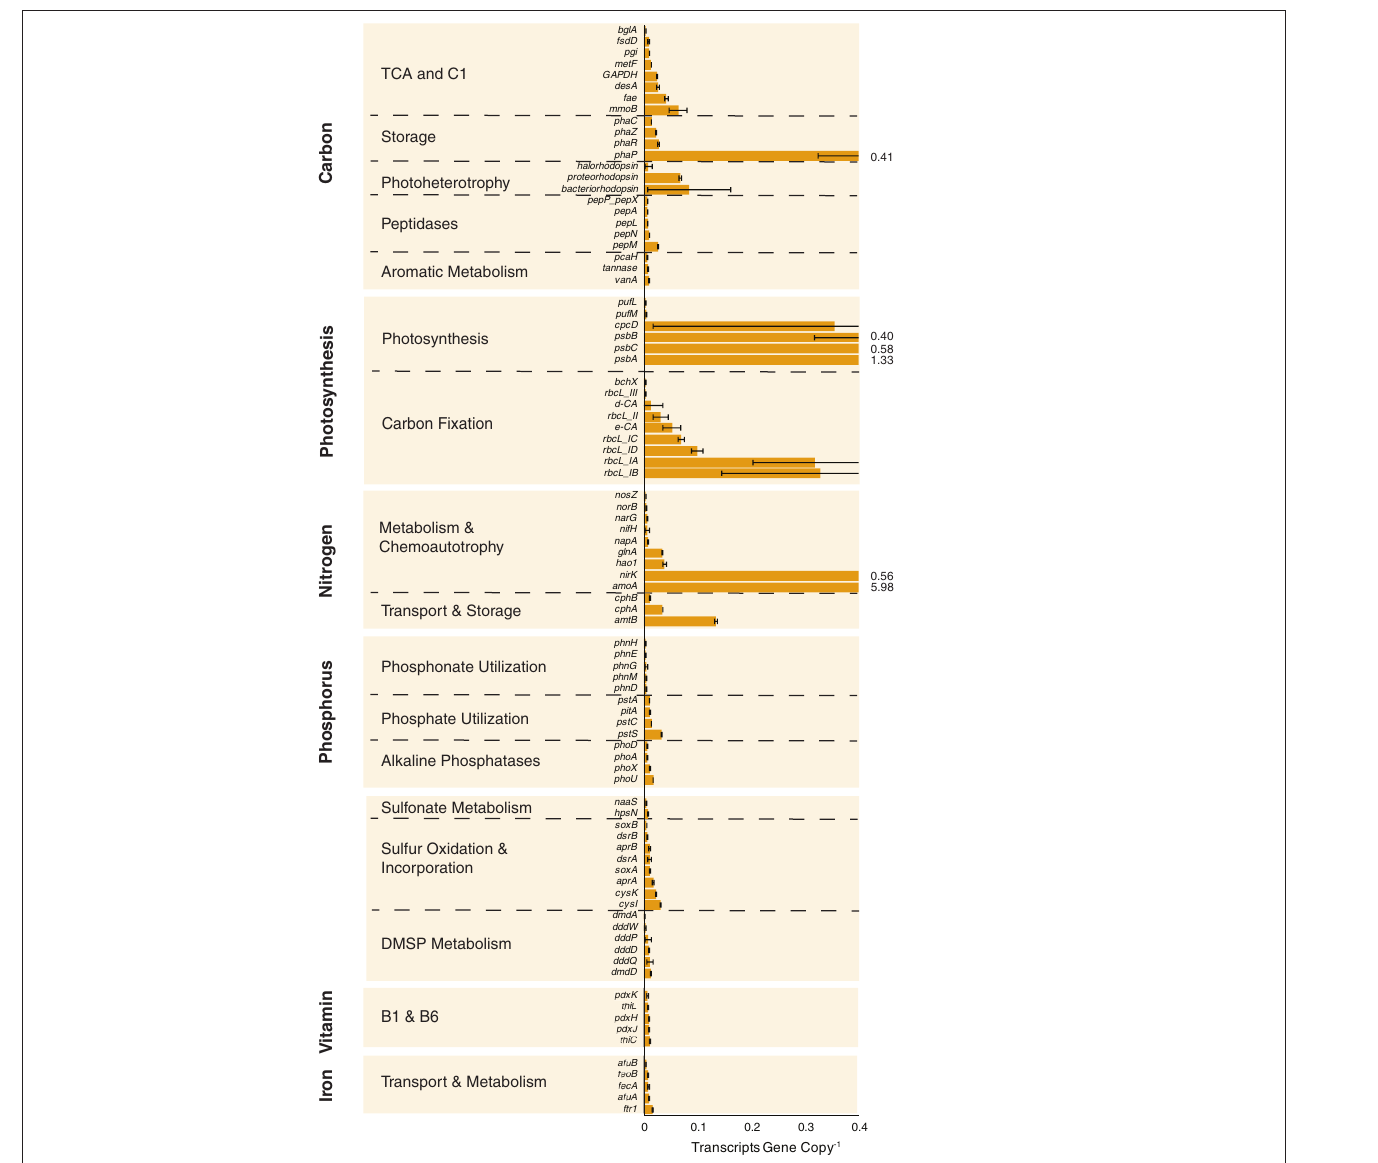
FIGURE 2 | Expression ratios (transcripts gene copy − 1 ) for 89 biogeochemically-relevant genes averaged across all stations and size fractions. Off-scale values are indicated to the right of the truncated bar. Expression dynamics by individual station and size fraction are shown in Figure 3 .